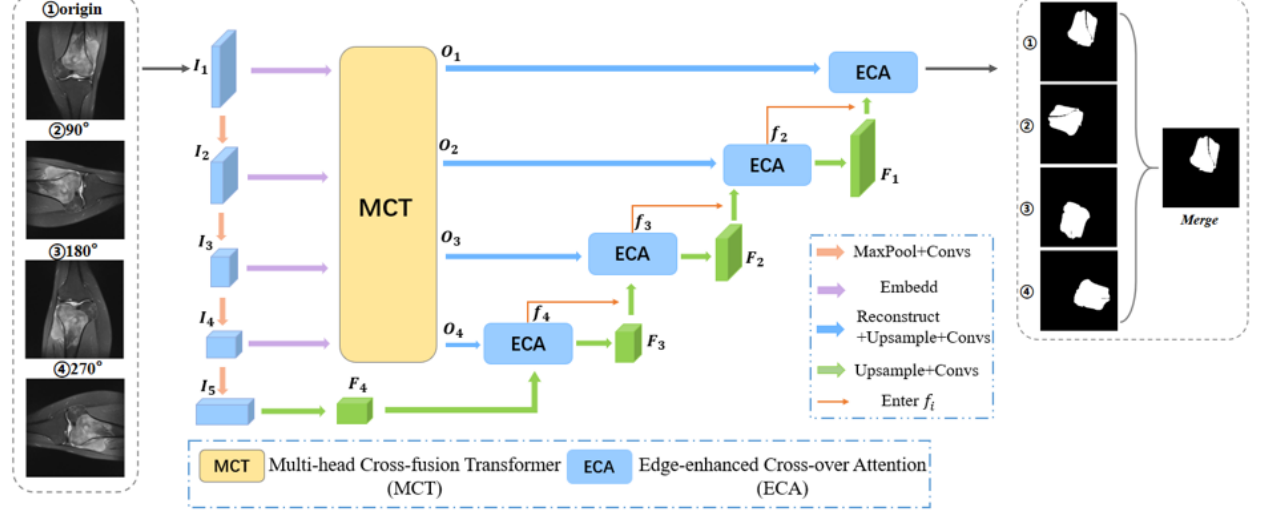
Figure 2. TBNet Segmentation Model.